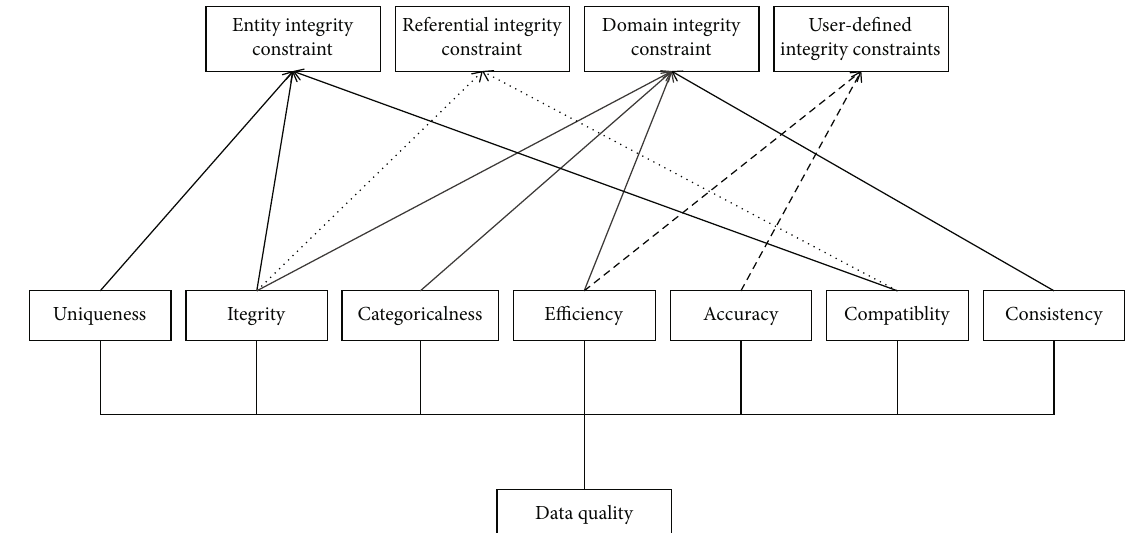
Figure 1: Data quality dimension of data warehouse preprocessing domain.